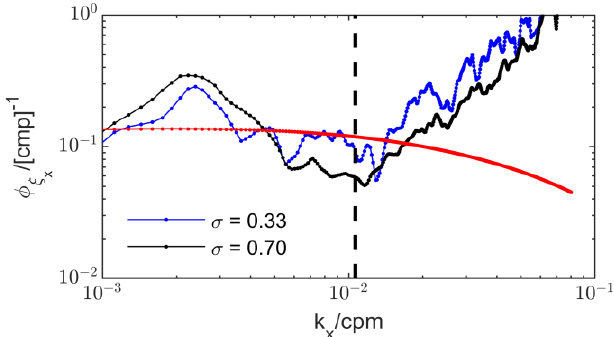
Figure A5. Estimation of uncertainty in 𝐸 𝑎 from horizontal slope spectra. The blue and black solid lines represent two horizontal spectra estimated from seismic reflections, while the red line is the GM76 reference horizontal spectra. The dots are the discrete 𝜙 𝜉 dashed black vertical line represents the interface between the internal wave subrange and noise subrange. The blue spectrum (uncertainty 0.33) fluctuates in a smaller range than the black spectrum (uncertainty 0.70)